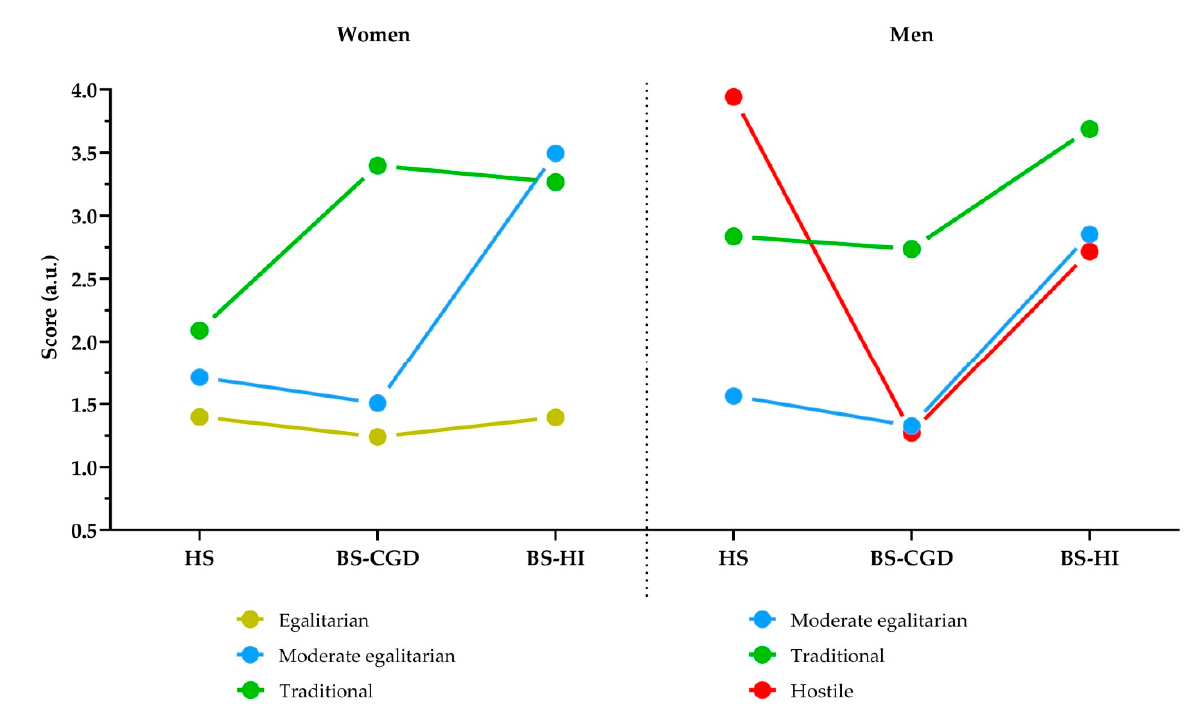
Figure 1. Types of sexism endorsement among women and men.